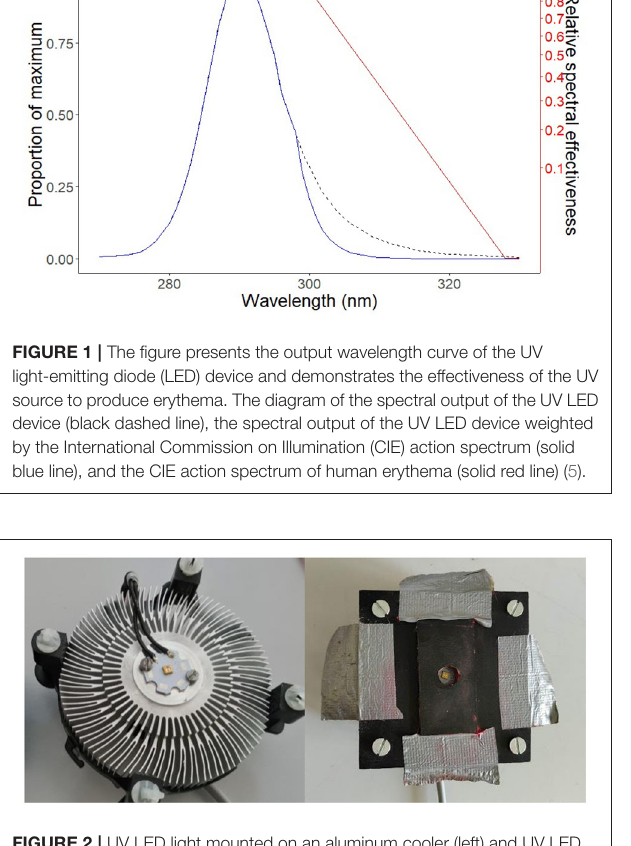
FIGURE 2 | UV LED light mounted on an aluminum cooler (left) and UV LED light with the template